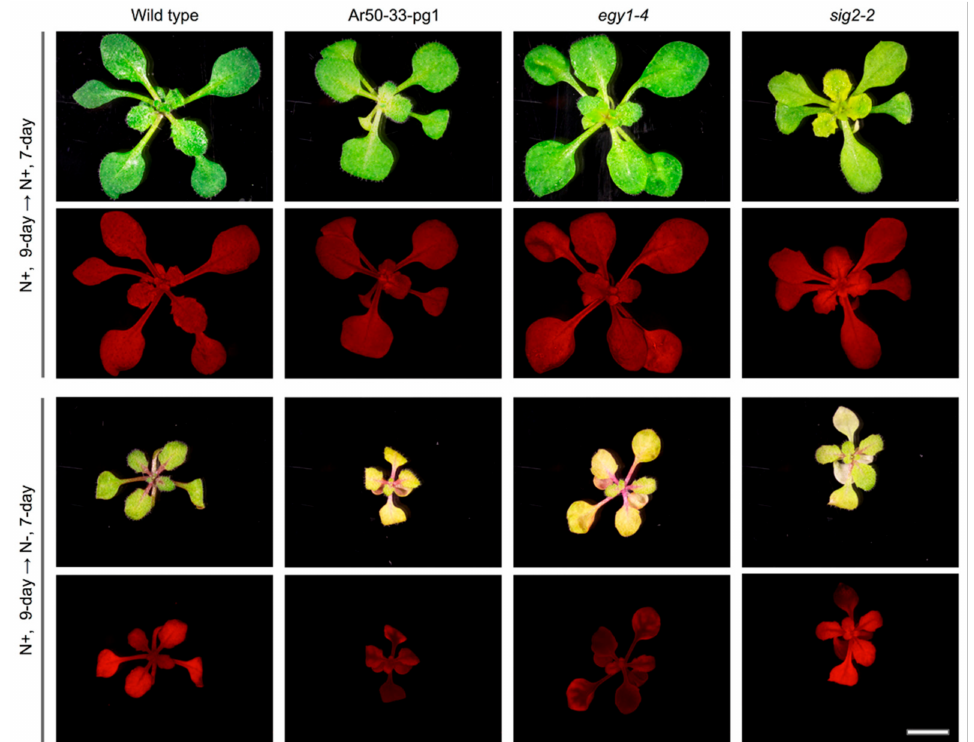
Figure 10. Plant growth analysis with nitrogen starvation. Bright-field and chlorophyll autofluores- cence images of wild type, Ar50-33-pg1, egy1-4 , and sig2-2 plants are shown. Seedlings were cultured on MS agar medium for the first 9 days and then transferred to either normal or nitrogen-depleted MS medium for subsequent culture for 7 days. Bar = 5